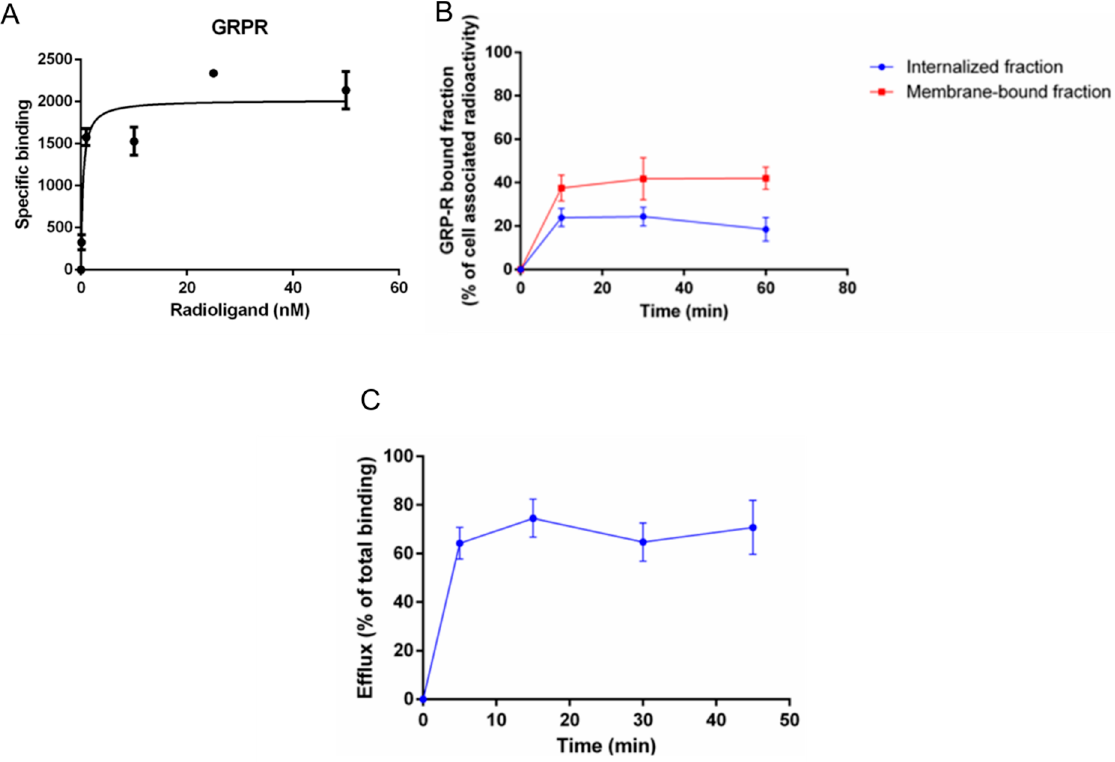
Figure 5. Saturation binding curve of [ 68 Ga]Ga-RM2 towards the GRP-R ( A ), internalized and membrane-bound fractions of [ 68 Ga]Ga-RM2 ( B ) and total efflux of [ 68 Ga]Ga-RM2 ( C ). All experiments were performed in triplicates on the PC-3 cell line.